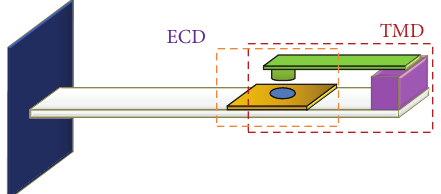
Figure 1: Schematic of magnetically tuned mass damper [19].